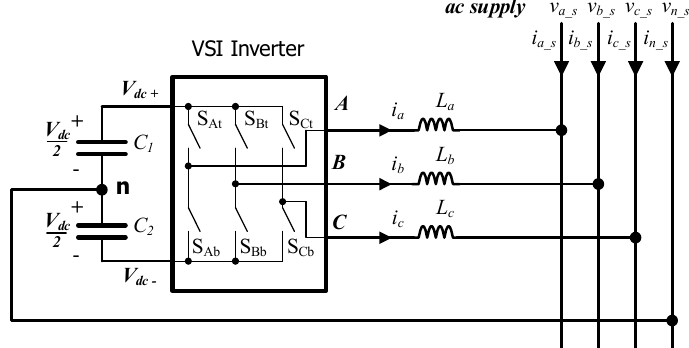
Figure 2. Three-leg four-wire grid-tied converter.